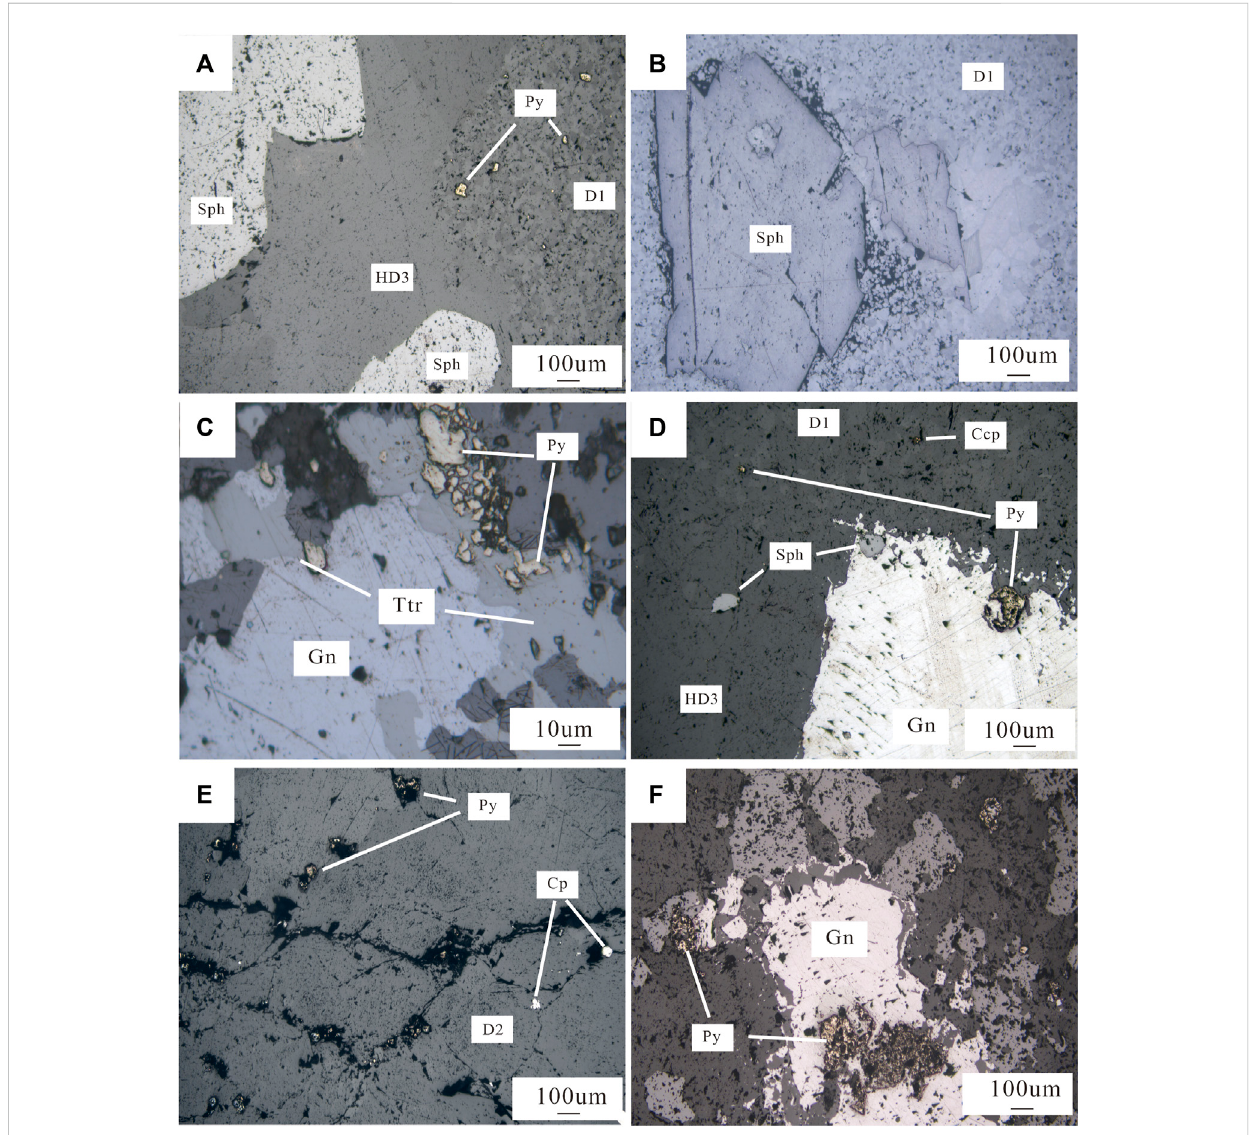
FIGURE 5 Sul fi demineraltextures andstructures fromtheFuliPb-Zn deposit. (A) Dolomite coexistswithsphalerite. (B) Sphalerite withagranularstructure. (C, D) Galena metasomatic pyrite and/or tetrahedrite. (E) Pyrite and chalcopyrite observed as bulk or disseminated in the dolomite (F) Metasomatic relict pyrite and xeno-morphic sphalerite in anhedral sphalerite